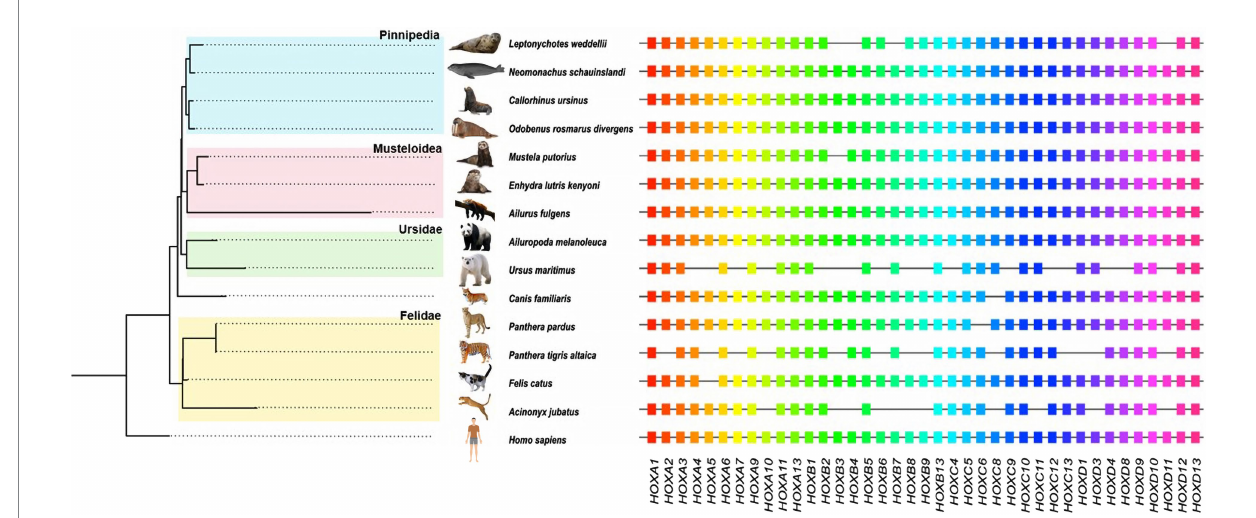
FIGURE 1 Phylogenetic analyses of Carnivora species based on the concatenated HOX gene family. The phylogenetic tree topology is the same as that of other large-data studies at the family level (Nyakatura and Bininda-Emonds, 2012; Upham et al., 2019). All 39 HOX genes collected from 15 species are shown on the right